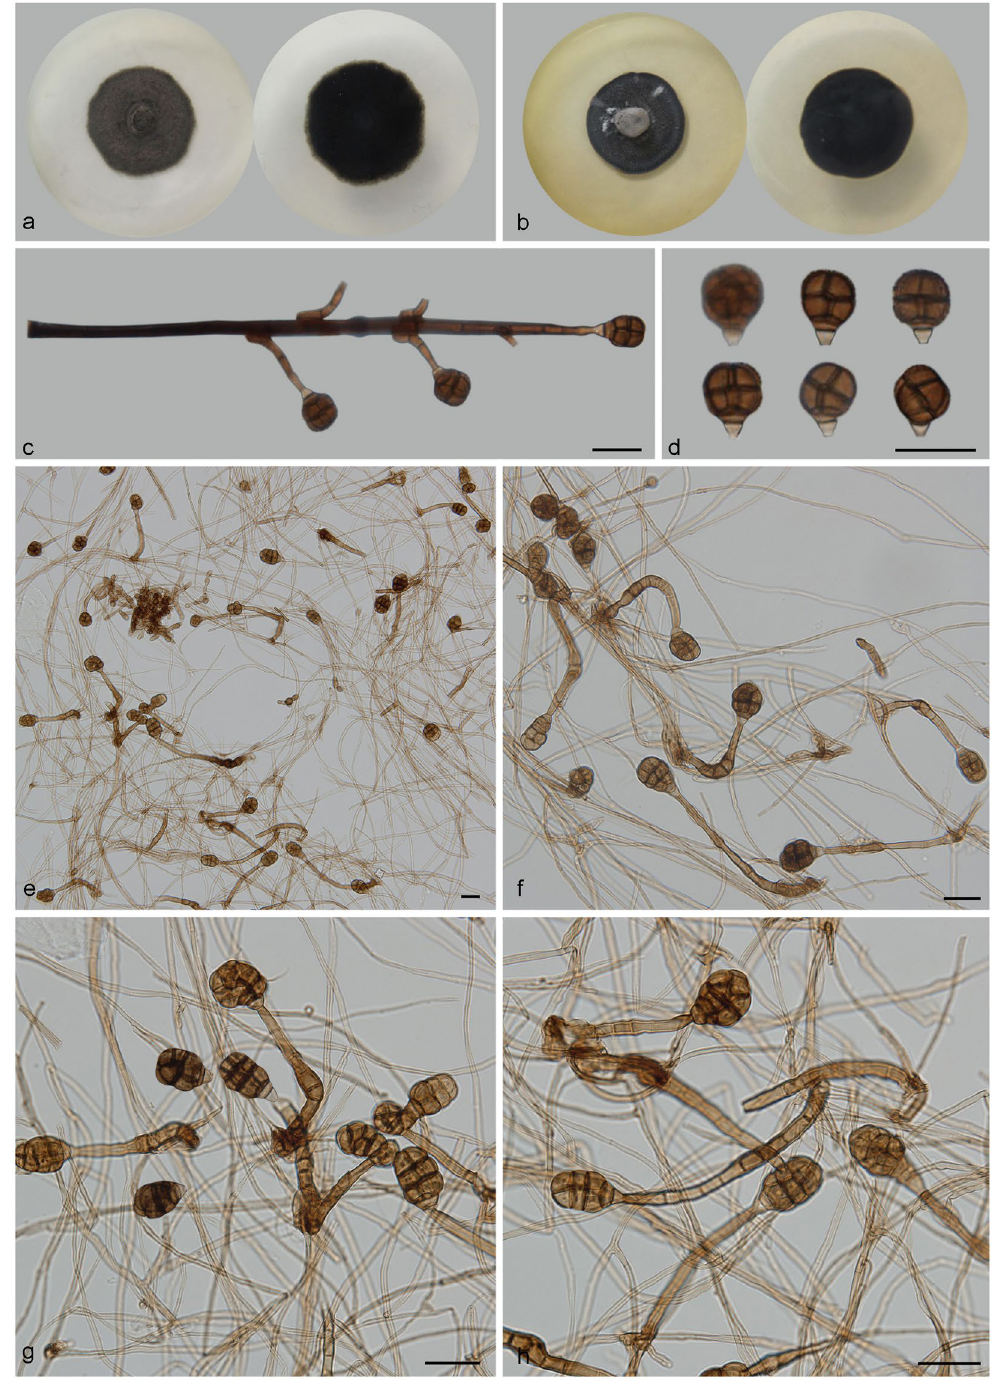
Figure 7. Acrodictys malabarica. ( a ) Colony on PDA (surface and reverse). ( b ) Colony on MEA (surface and reverse). ( c , d ) From natural substrate (HSAUP H9509): ( c ) Conidiophores with fertile branches and conidia, ( d ) Conidia. ( e – h ) From PDA (CGMCC 3.18648): Conidiophores and conidia. — Scale bars = 20 μ